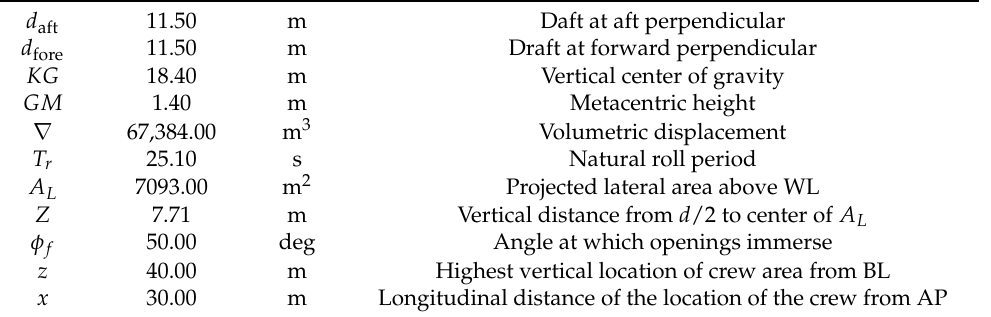
Figure 18. Isometric view of C11 container ship geometry in section-based GF format. Blue lines mark the deck edge. See Section 6 for a link to download this geometry file. Table 14. Loading conditions of C11 container ship.